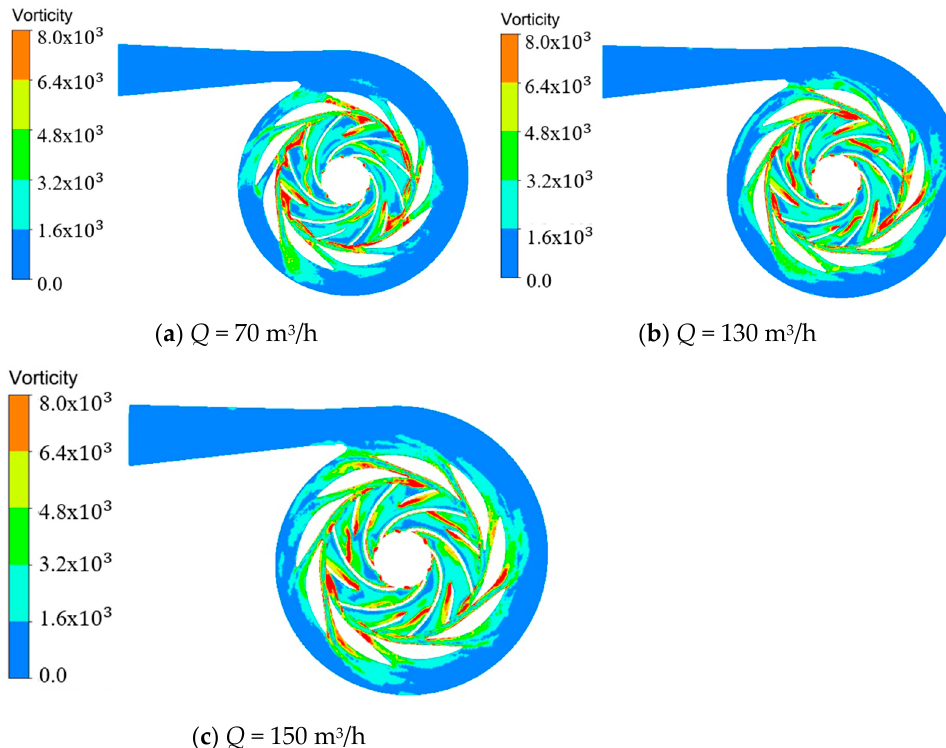
Figure 13. Vorticity distribution at different flow rates.